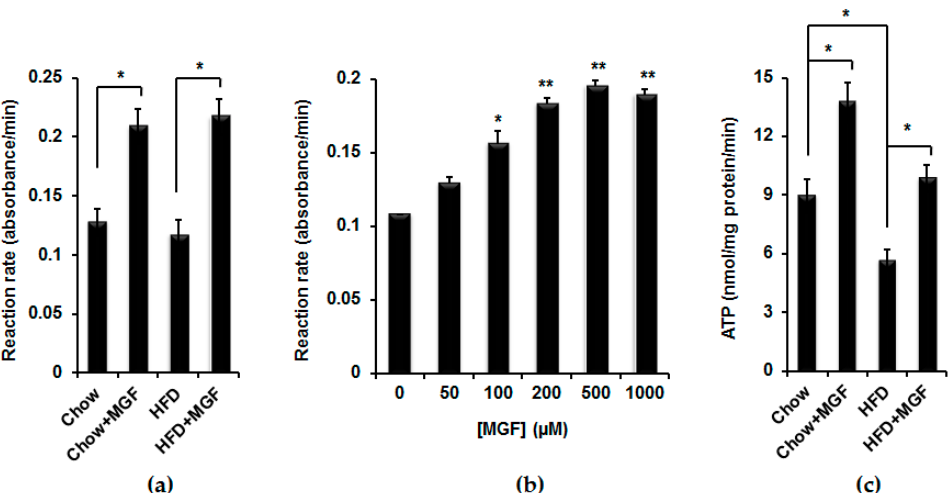
Figure 4. MGF enhances SDH activity and increases ATP production. Mitochondria were isolated from quadriceps of mice treated with chow or HFD ± MGF for 16 weeks ( n = 6/group) ( a ) or C2C12 myotubes treated with various concentrations of MGF for 4 h ( b ). In vitro experiment presented in ( b ) was repeated for three times. The comparisons are between the rate at each MGF concentration with the rate when [MGF] = 0; ( c ) ATP production in freshly isolated mitochondria from quadriceps of mice treated with chow or HFD ± MGF for 16 weeks ( n = 6/group). Values are average ± SEM. * p < 0.05, ** p < 0.01.